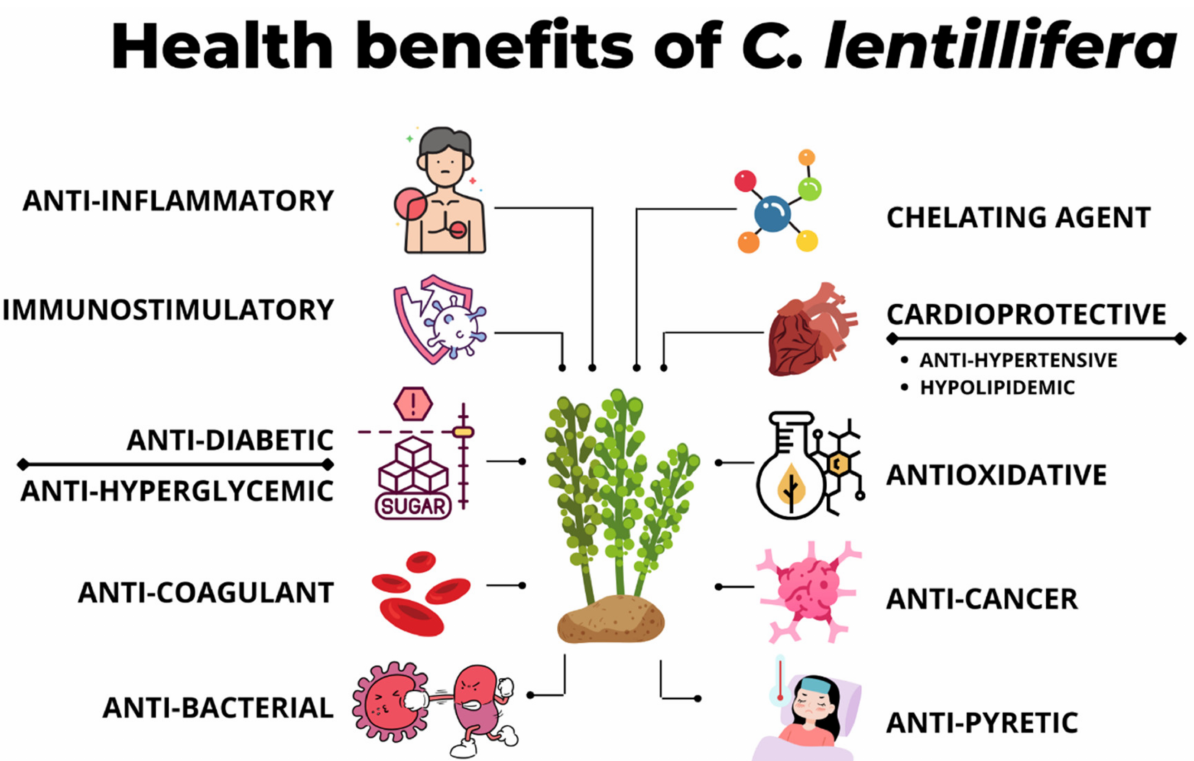
Figure 2. Overview of health benefits reported of C. lentillifera .